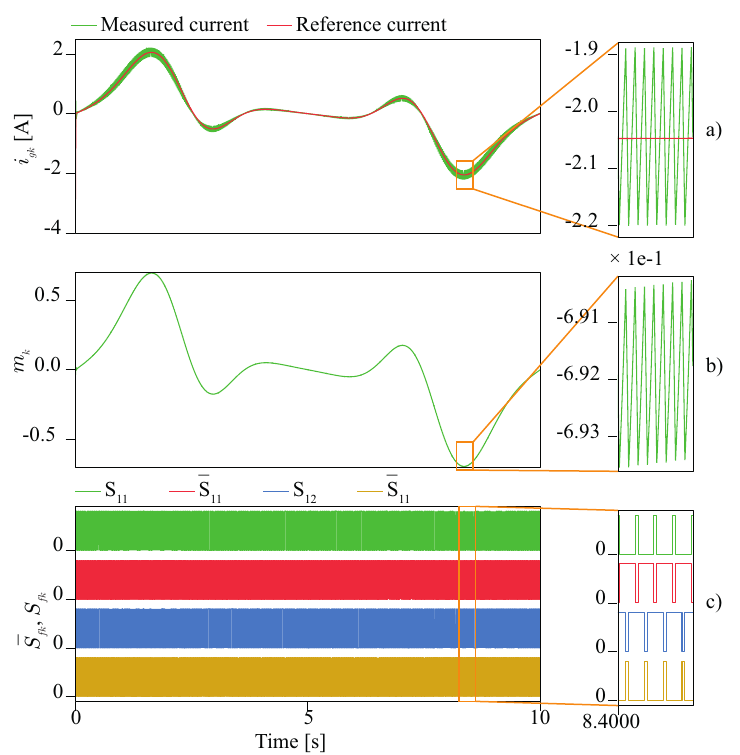
Figure 8. ( a ) Measured current and reference current signals i gk . ( b ) Modulation index m k . ( c ) Switching signals S fk